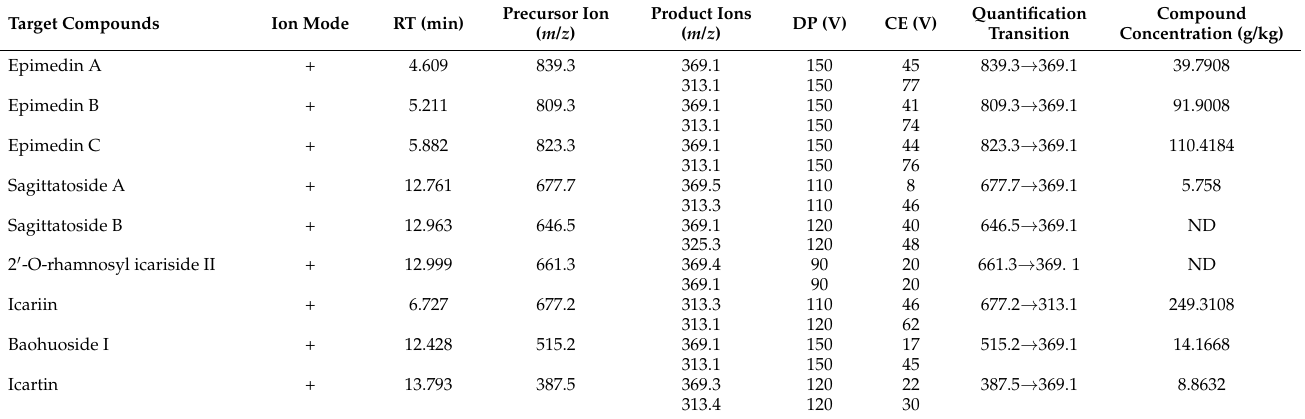
Table 2. List of main isopentenyl flavonols and their MRM parameters, from